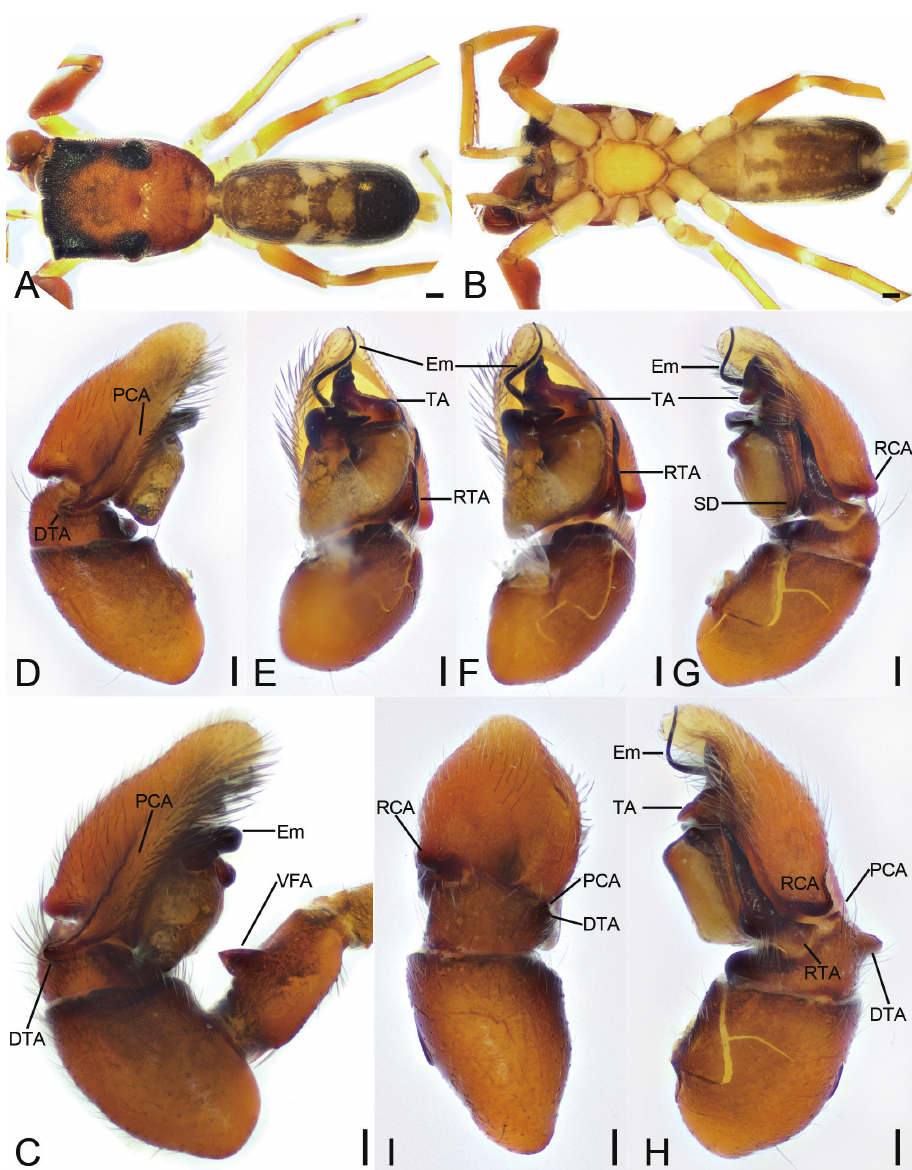
Figure 9. Synagelides shuqiang sp. nov., holotype male A habitus, dorsal view B same, ventral view C palp, detail of ventral femoral apophysis, prolateral view D same, prolateral view, slightly dorsal E same, ventral view F same, ventral view, slightly retrolateral G same, retrolateral view H same, retrolateral view, slightly dorsal I same, dorsal view. Abbreviations: DTA – dorso-prolateral tibial apophysis, Em – embolus, PCA – postero-prolateral cymbial apophysis, RCA – postero-retrolateral cymbial apophysis, RTA – retro- lateral tibial apophysis, SD – sperm duct, SS – scale-like serrations, TA – terminal apophysis, VFA – ven- tral femoral apophysis. Scale bars: 0.2 mm ( A, B ); 0.1 mm ( C ); 0.05 mm ( D–I